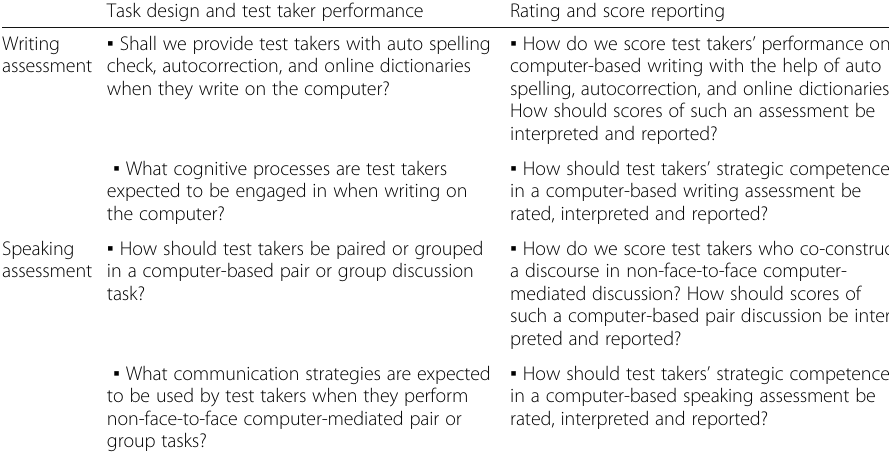
Table 1 Examples of issues with an interactionalist approach in the context of computer-mediated language